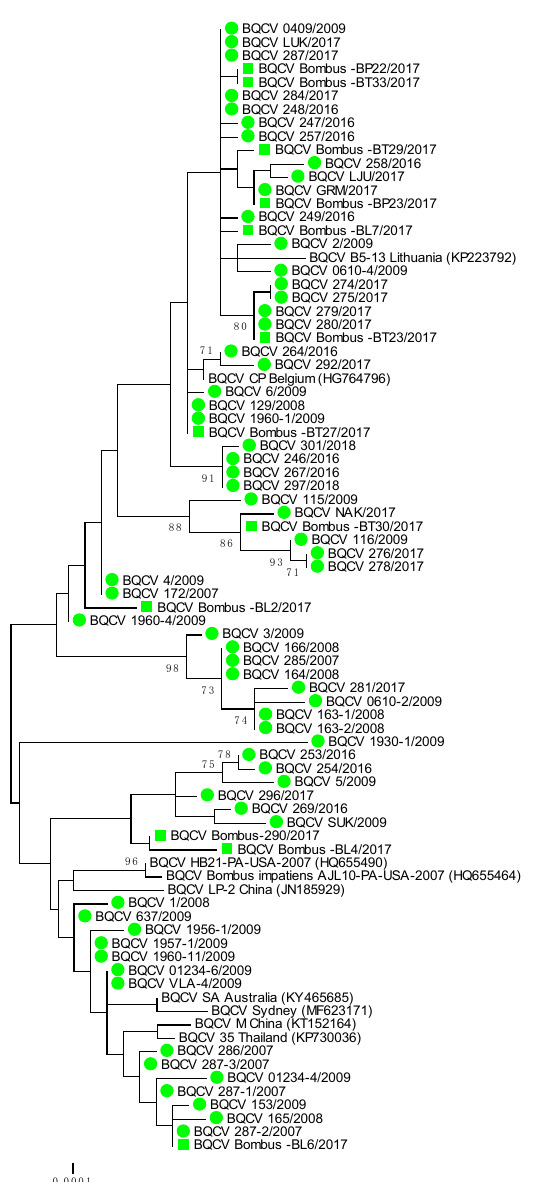
Figure 3. Phylogenetic comparison of 63 BQCV positive samples of honeybees ( ● ) and 12 positive bumblebee samples ( ■ ) in Slovenia (nt genome position between 7788 and 8440, numbering according to strain BQCV/144l, MN565034). The comparison was performed on the determined sequence of the 653 nucleotides of the viral genome region encoding the capsid protein together with the nine genetically closest strains detected in GenBank (presented with accession numbers).